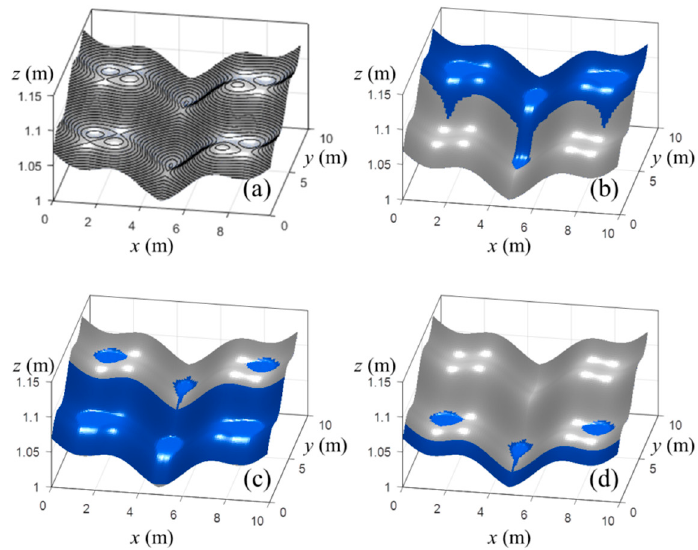
Figure 6. Computed water surface (blue) at ( a ) t = 0 min, ( b ) t = 7 min, ( c ) t = 27 min, ( d ) t = 35 min, and basin topography.